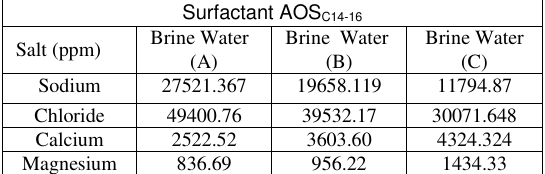
Table 1: Composition of Synthetic Brine Water for Surfactant AOS C14-16 Salt